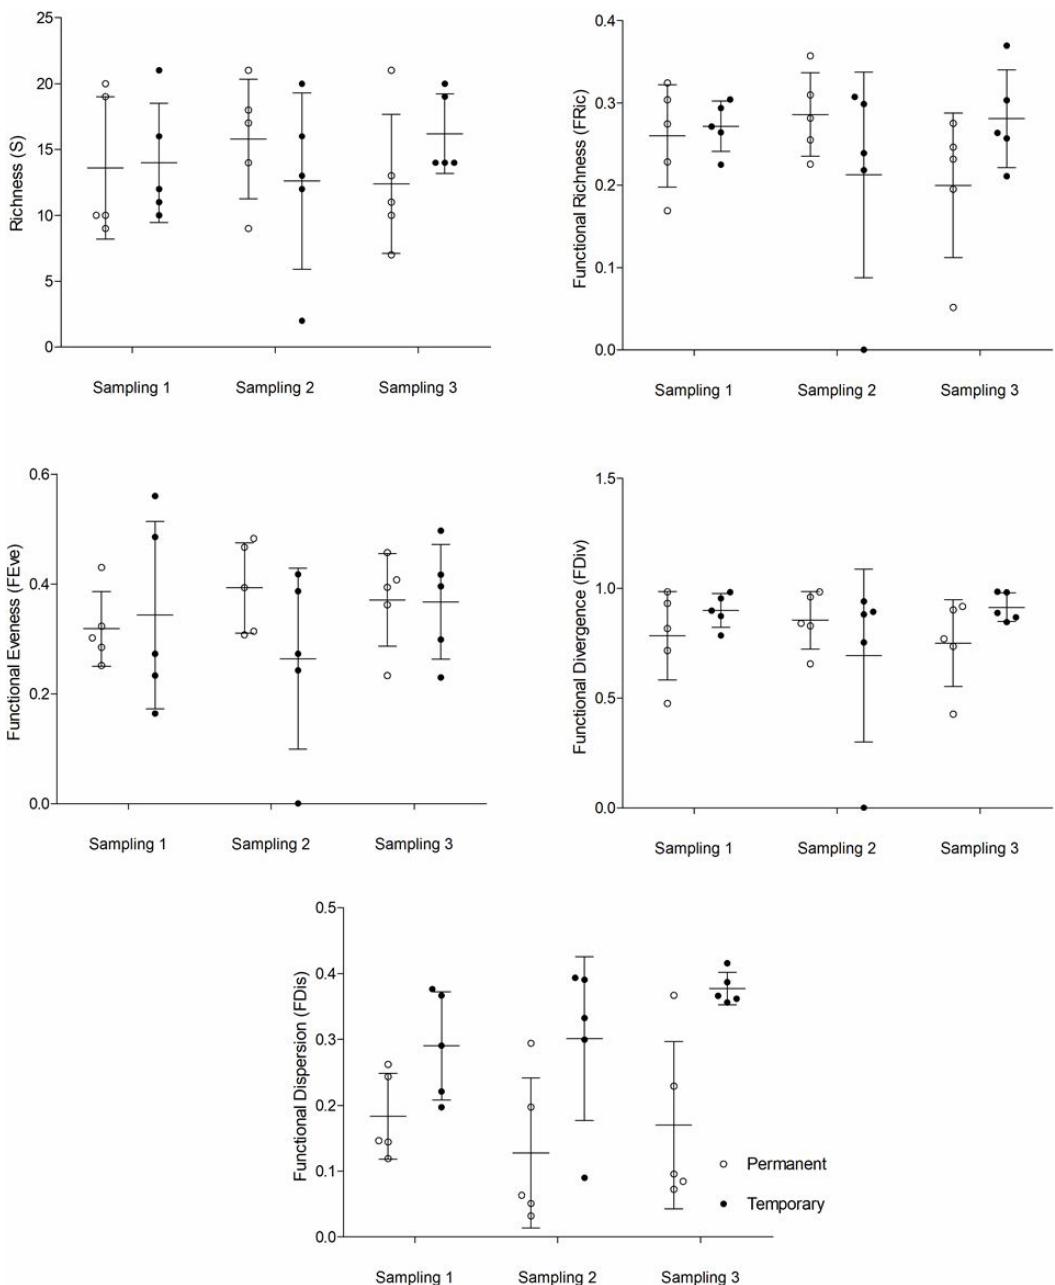
Figure 3. Values of Functional Evenness (FEve), Functional Richness (FRic), Functional Divergence (FDiv), Richness (S) and Functional Dispersion (FDis) for temporary ponds and permanent lagoons located in Restinga de Jurubatiba National Park, Rio de Janeiro, Brazil. Significant difference was found between temporary and permanent environments for FDis (RM-ANOVA, F=14.72, p=0.005 ). The samples were collected in 6 and 20 of April and 13 of May